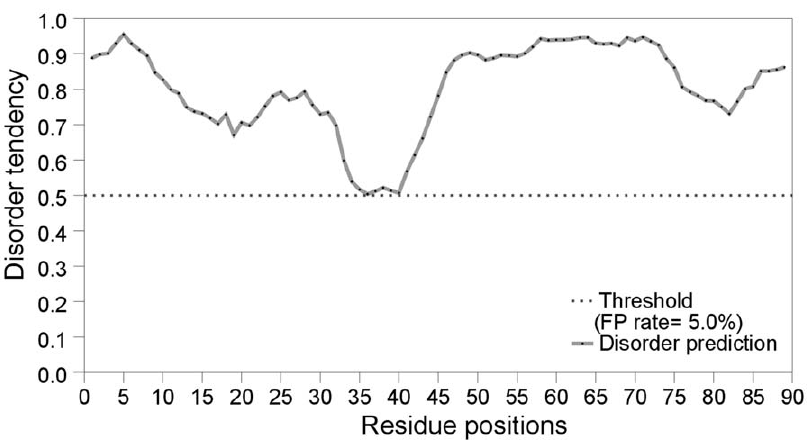
Figure 8. Predicted structural disorder in Ure2 prion domain using metaPrDOS [ 37 ] . Note that all residues are predicted to be disordered.